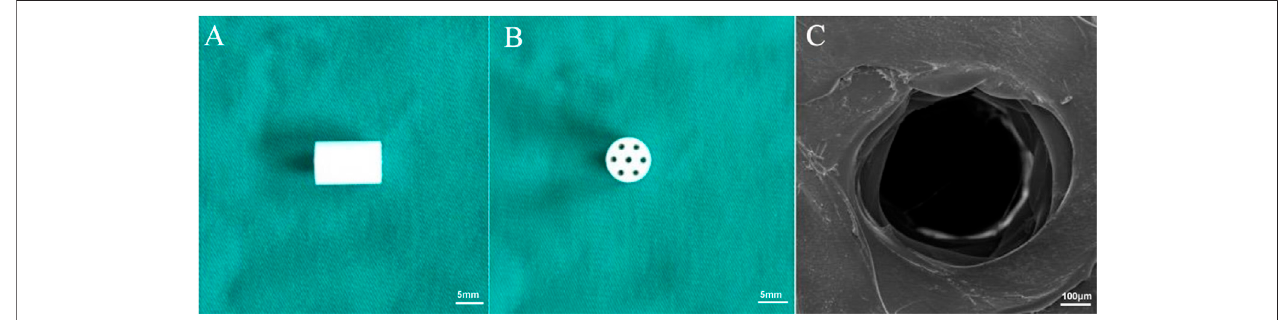
FIGURE 1 | Morphology of the 3D printed scaffolds. (A) The side view and (B) top view of the prepared scaffolds. (C) SEM images of PLGA scaffolds.